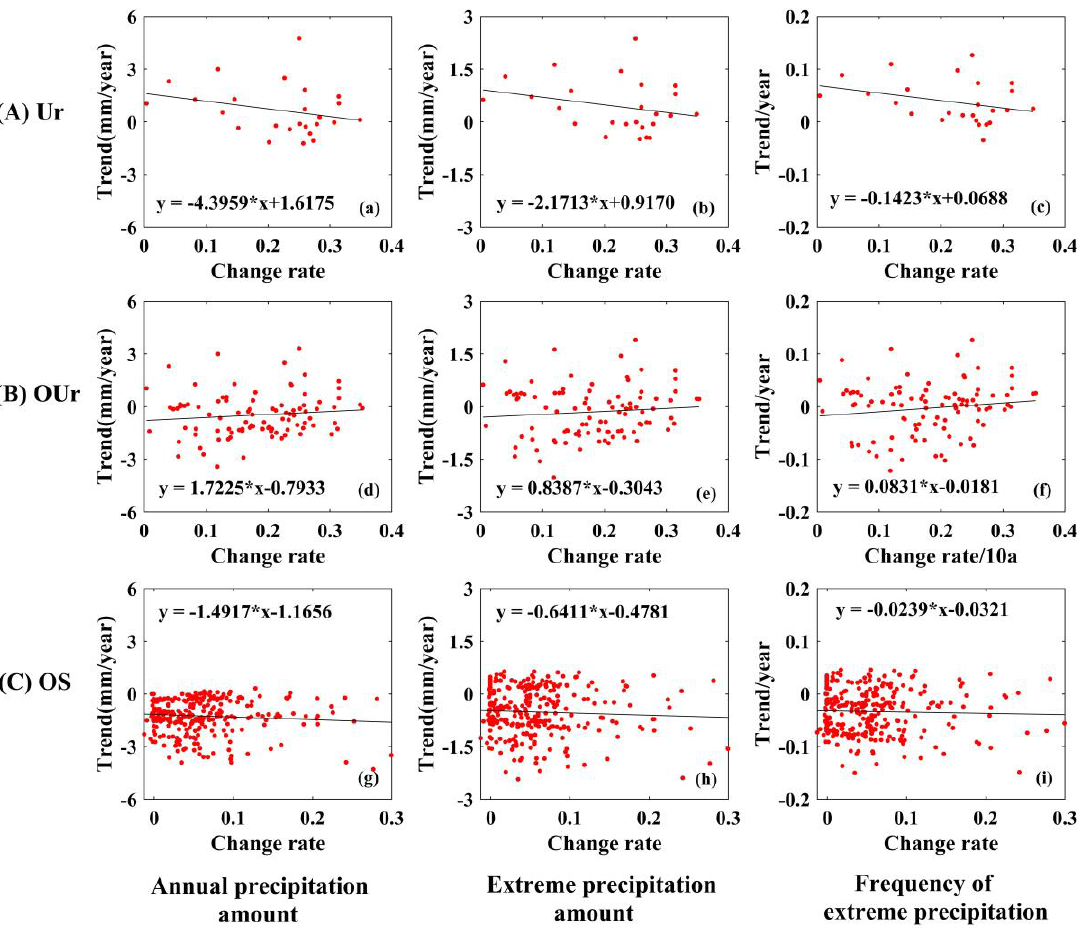
Figure 10. Scatter plots of the precipitation trend and changes in the rate of built-up area percentage for: the ( A ) Ur; ( B ) OUr; and ( C ) OS regions.